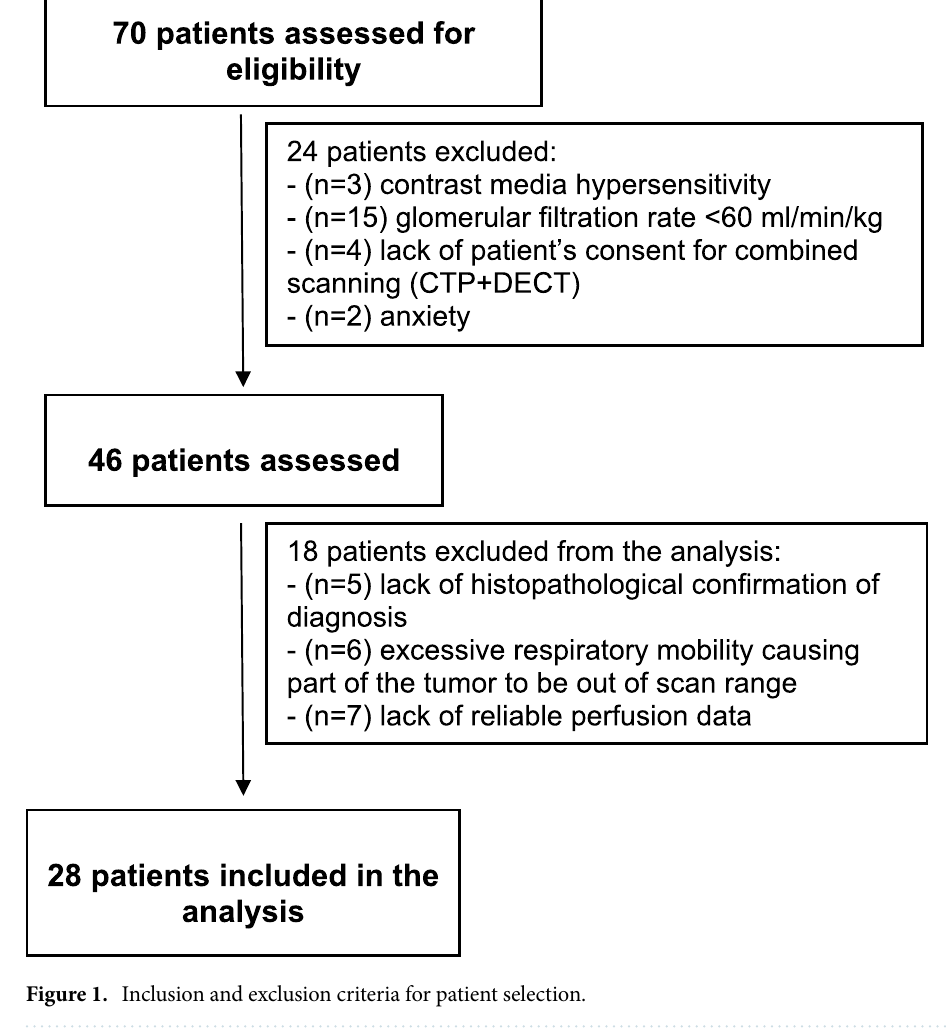
Figure 1. Inclusion and exclusion criteria for patient